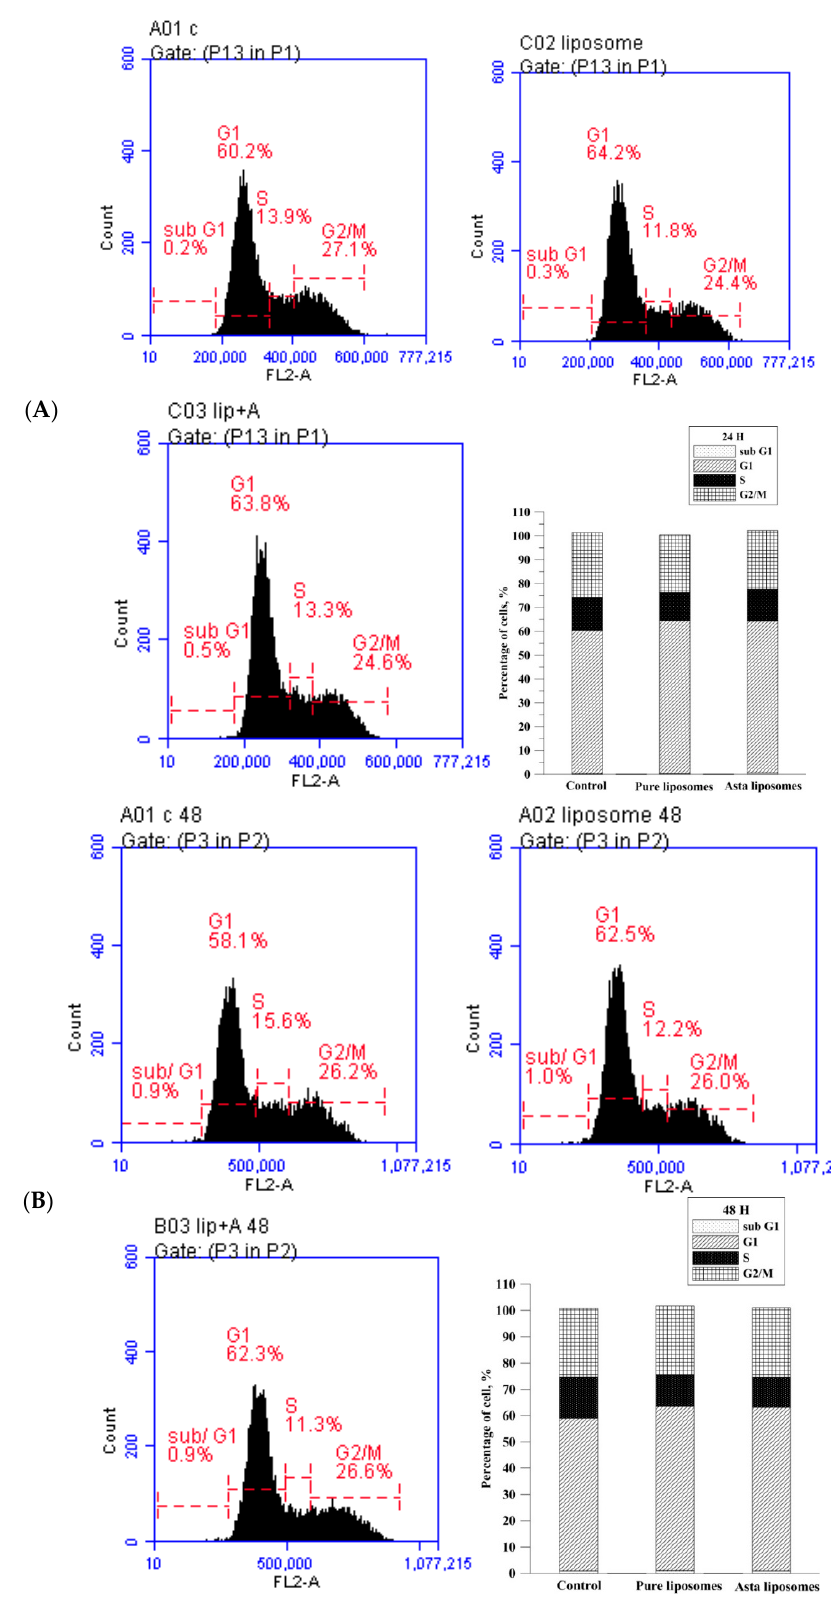
Figure 3. Cell cycle distribution analysis of L929 fibroblasts after ( A ) 24- and ( B ) 48-h treatment with 0.01 mg/mL pure liposomes or Asta-lipo. No significant differences were found in the cell cycle phases prior to treatment with pure liposomes or Asta-lipo.